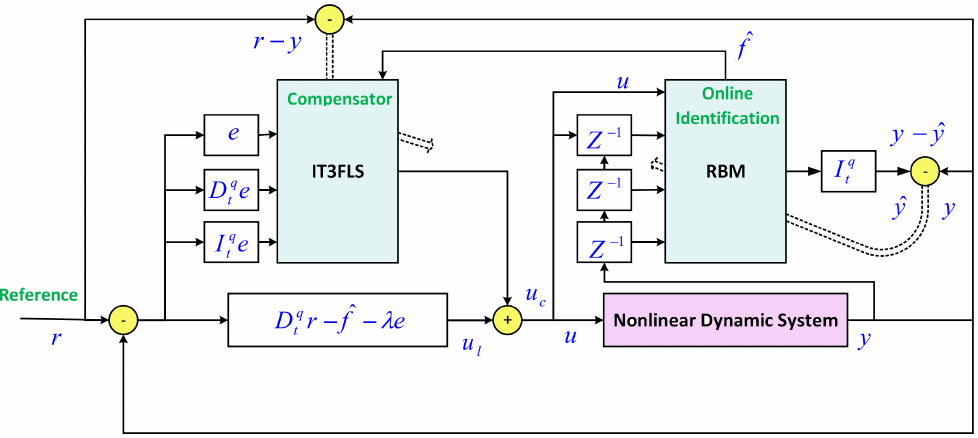
Figure 3. The suggested control block